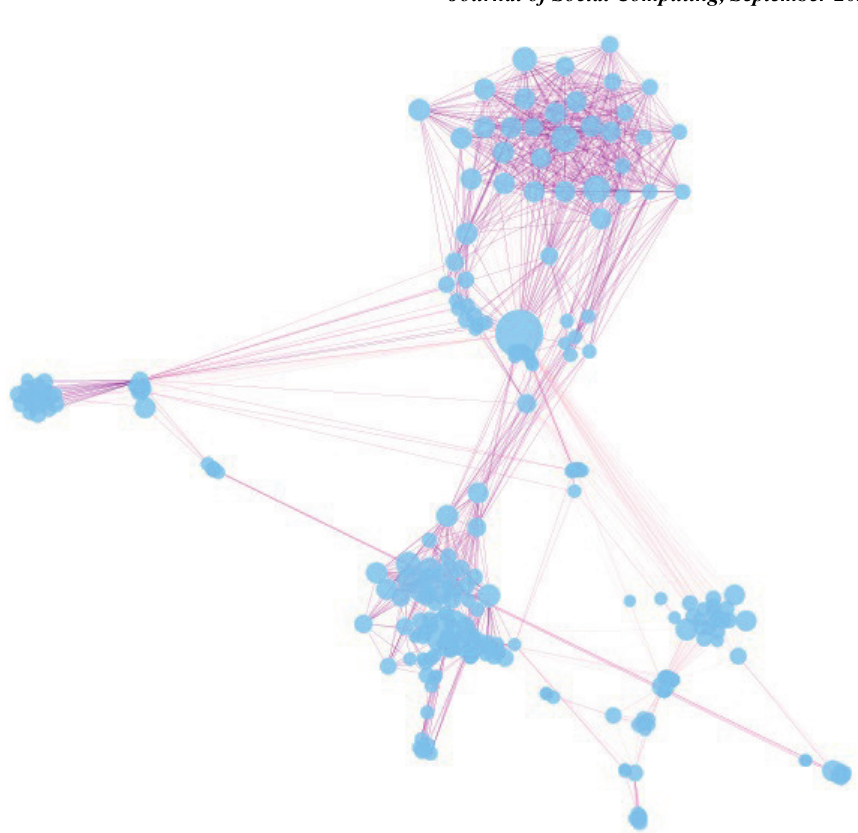
Fig. 3 Example of the dynamic